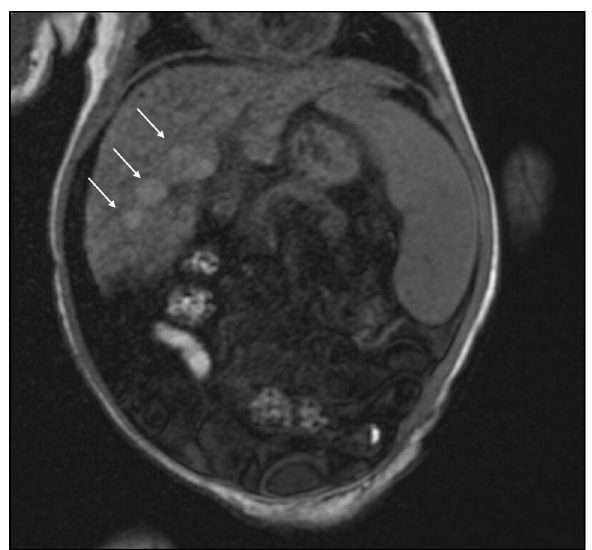
Figure 2. Non-contrast, T1-weighted abdominal MRI from DOL 68 showing the patient’s liver enlargement and irregular surface consistent with cirrhosis and multiple regenerative nodules (white arrows). The spleen is also enlarged, and there is abdominal distention secondary to ascites.